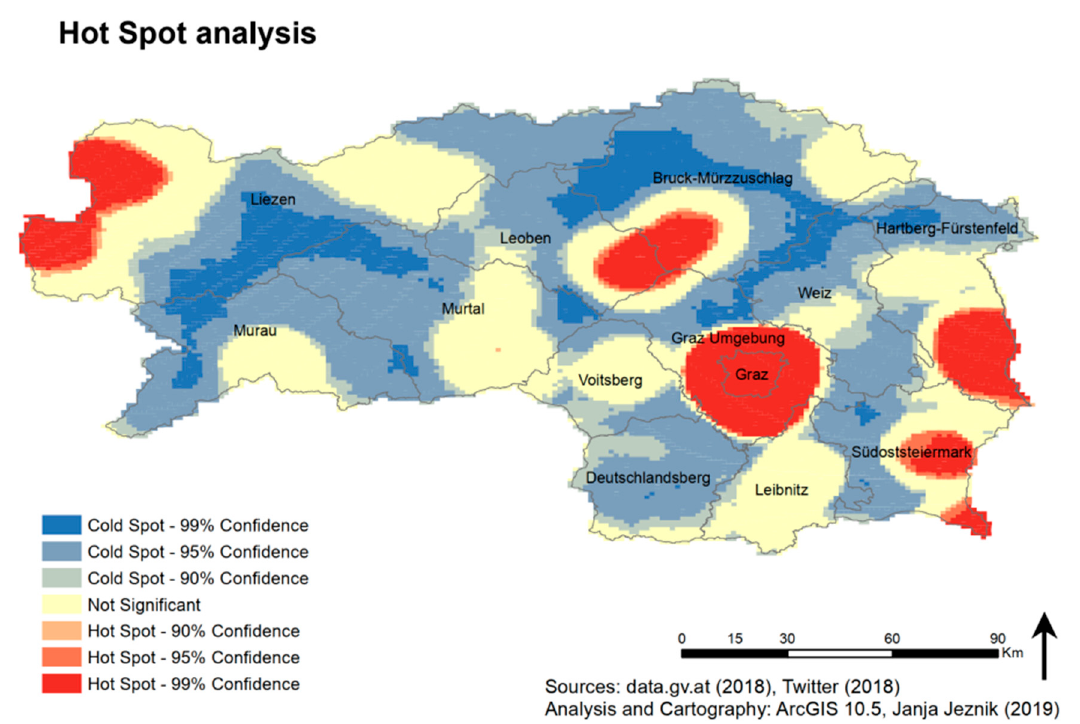
Figure 7. Optimized Hot Spot analysis of the tweets and the districts of the Province of Styria. The tweets are aggregated, based on a fishnet with 1 km cell size. Regions having a red color represent a hot spot, whereas regions colored in blue are regarded as cold spots.